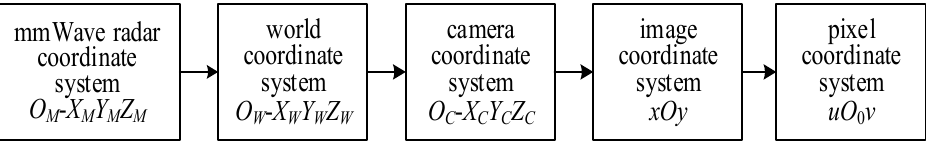
Figure 3. Transformation between different coordinate